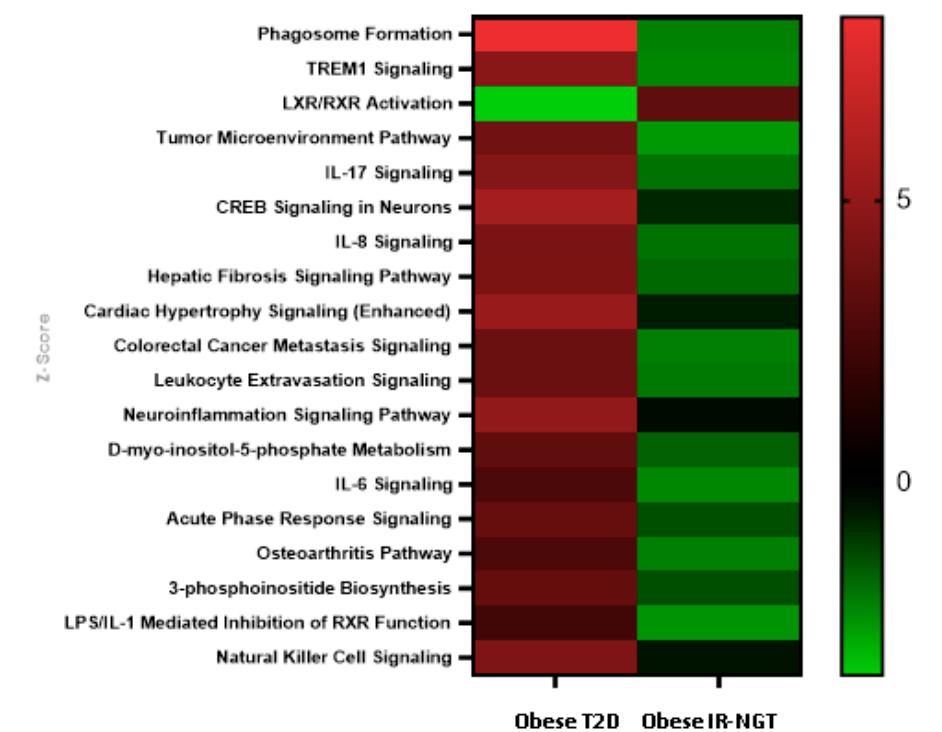
Figure 8. Top dysregulated canonical signaling pathways. The log ( p -value), z-score and ratio of top significantly activated canonical signaling pathways are indicated in red color. A scale from light green to dark red indicates the level of inhibition/activation in/of the canonical signaling pathways, respectively.